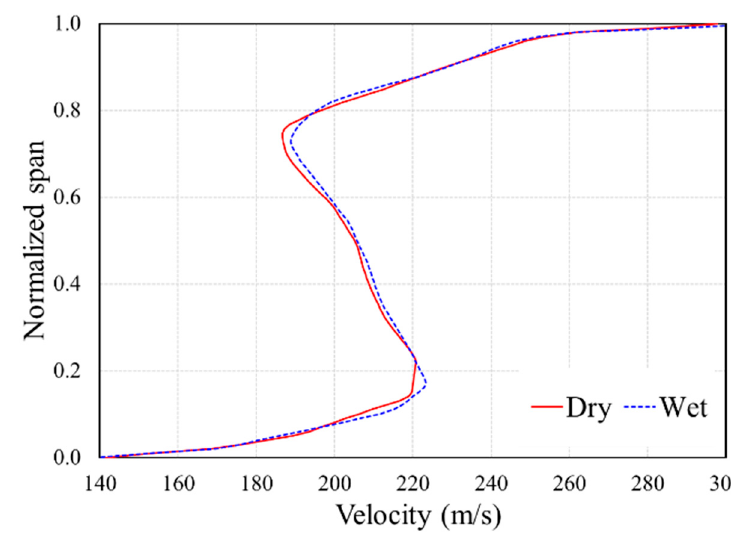
Figure 7. Impeller outlet velocity distribution of dry and wet compression.